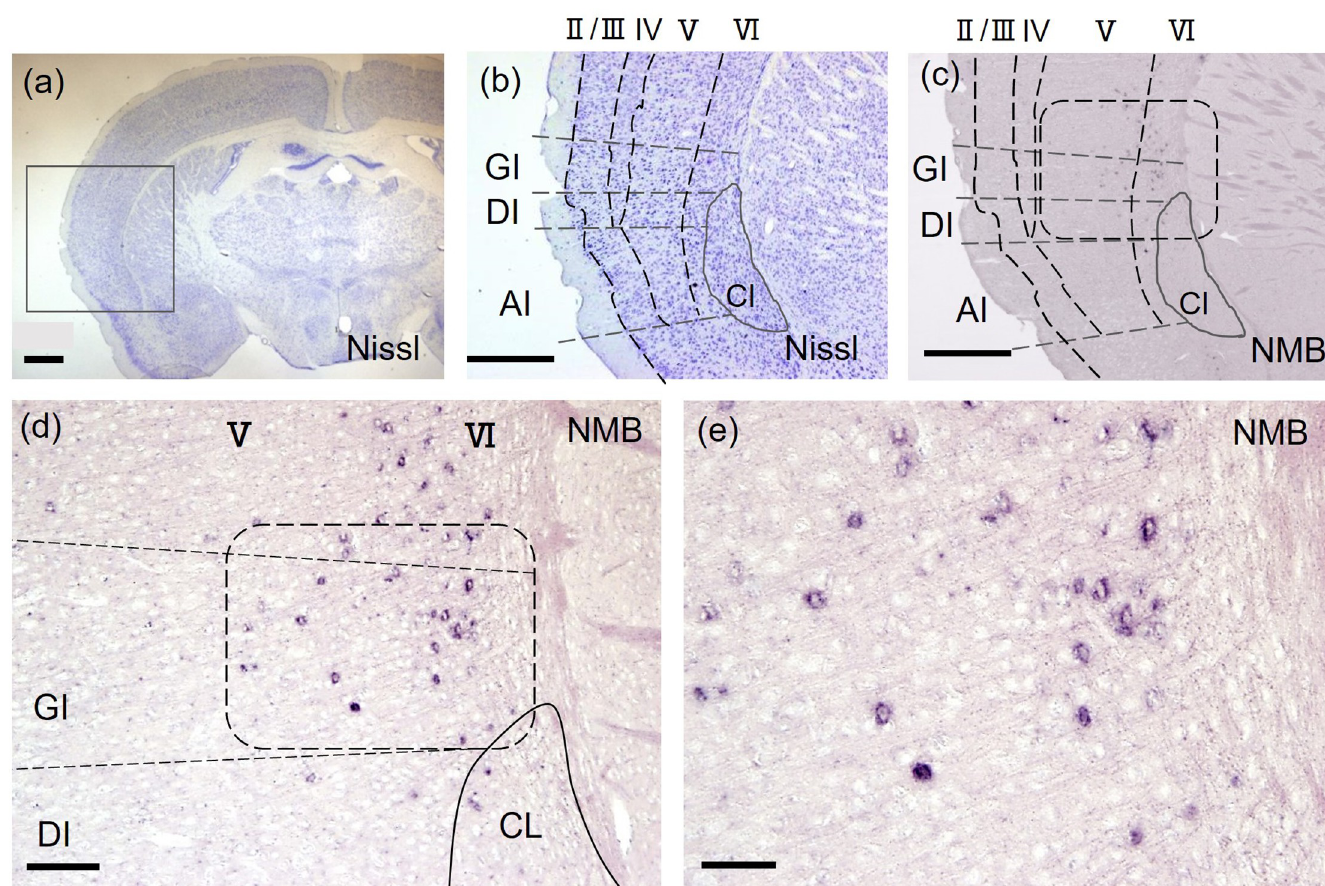
Fig 7. NMB was expressed in the deep layers, layer Ⅴ and layer Ⅵ (GI, DI, and AI), with the highest expression in layer VI neurons of the mouse insular cortex. NMB expression was scattered in layer Ⅴ and Ⅵ , with the highest expression in layer VI. (d) and (e) are the higher magnification images of the rounded square boxes in (c) and (d). A square in Nissl stained (a) is shown as (b). (b) and (c) are adjacent sections. Scale bars (a): 500 μ m, (b), (c): 200 μ m, (d) 100 μ m, (e): 50 μ m.